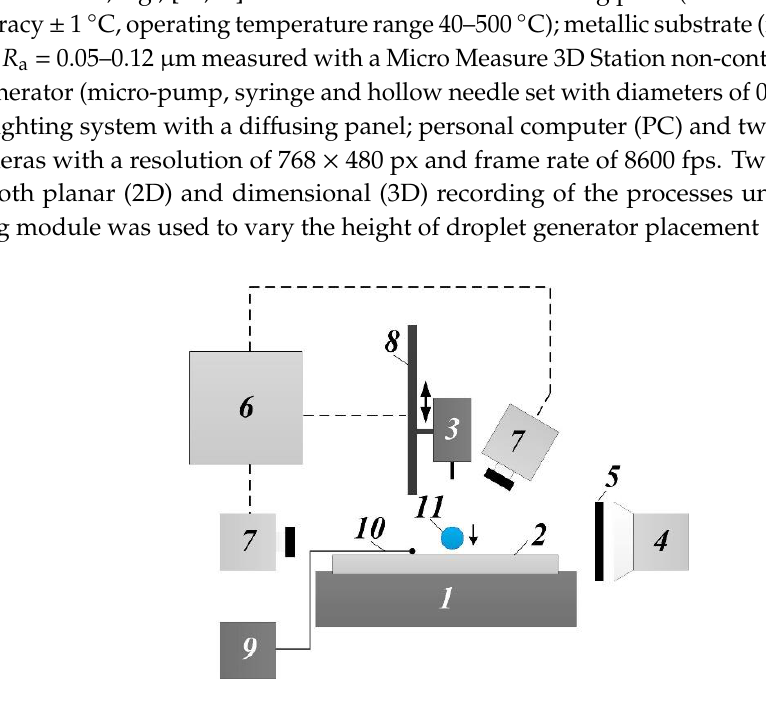
Figure 1. Scheme of the experimental setup: heating plate ( 1 ), substrate ( 2 ), droplet generator ( 3 ), LED spotlight ( 4 ), diffuser ( 5 ), PC ( 6 ), video camera ( 7 ), linear positioning module ( 8 ), data acquisition device ( 9 ), thermocouple ( 10 ), droplet ( 11 ).